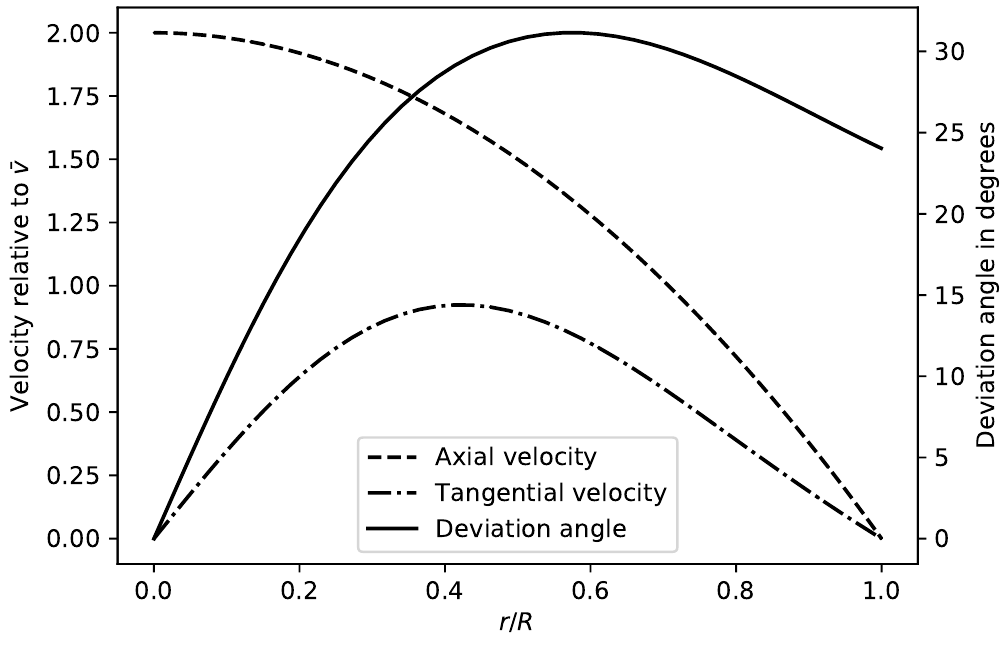
Figure 2. Axial and tangential velocity profiles and optimal theoretical fundamental swirl mode when S = 0.2, with the deviation angle between the two velocity components included. Note that the radial velocity component is generally small, as shown in